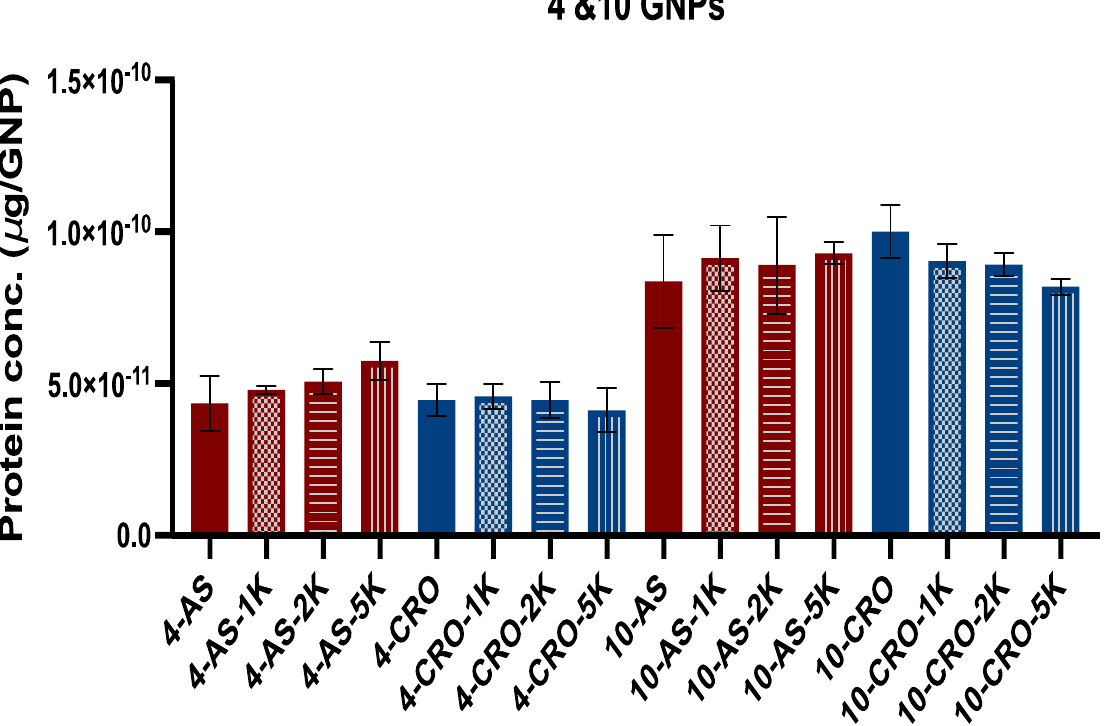
Figure 4. Comparison between 4 and 10 nm GNPs conjugated with AS1411/CRO indicates the numbers of adsorbed proteins on 10 nm GNPs are almost 2-fold the numbers found on 4 nm GNPs. Each data point represents the mean ± standard deviation (SD) of triplicate experiments.